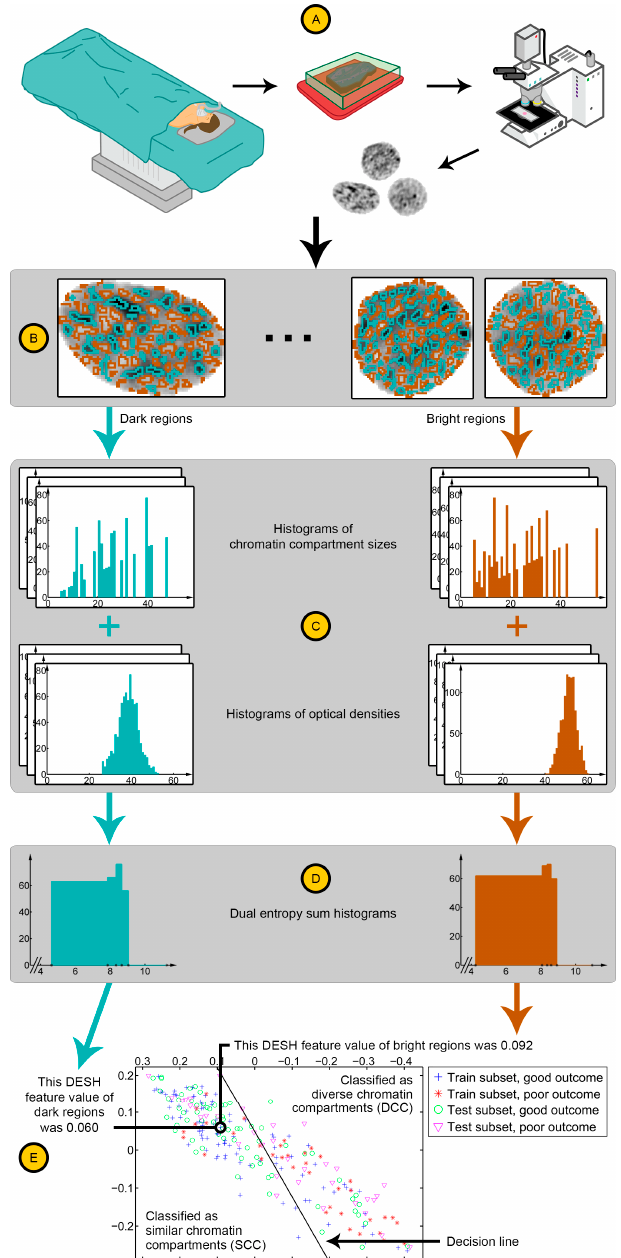
Figure 1. Pipeline for assessing the marker of diversity of chromatin compartments. ( A ) Tumour cell nuclei from a formalin-fixed and para ffi n-embedded (FFPE) block are imaged by a microscope. ( B ) The segmentation algorithm automatically finds dark (shown in cyan) and bright (shown in light brown) regions, corresponding to relatively highly and relatively weakly condensed chromatin compartments, respectively. ( C ) The histogram of chromatin compartment sizes and the histogram of optical densities in the compartments are computed separately for the dark and bright regions in the nuclear image. The entropy of each histogram is then summed, giving a single continuous value that describes the diversity of dark chromatin compartments in the nuclear image, and similarly a value that describes the bright chromatin compartments. ( D ) The entropy sums of a patient’s nuclear images provide the dual entropy sum histogram (DESH) of the dark regions and the DESH of the bright regions. ( E ) The two adaptive DESH features are computed, one from each DESH. The classification of a patient, as having either diverse chromatin compartments (DCC) or similar chromatin compartments (SCC), is determined by comparing the two features to the decision line. DCC, diverse chromatin compartments; DESH, dual entropy sum histogram; FFPE, formalin-fixed and para ffi n-embedded; SCC, similar chromatin